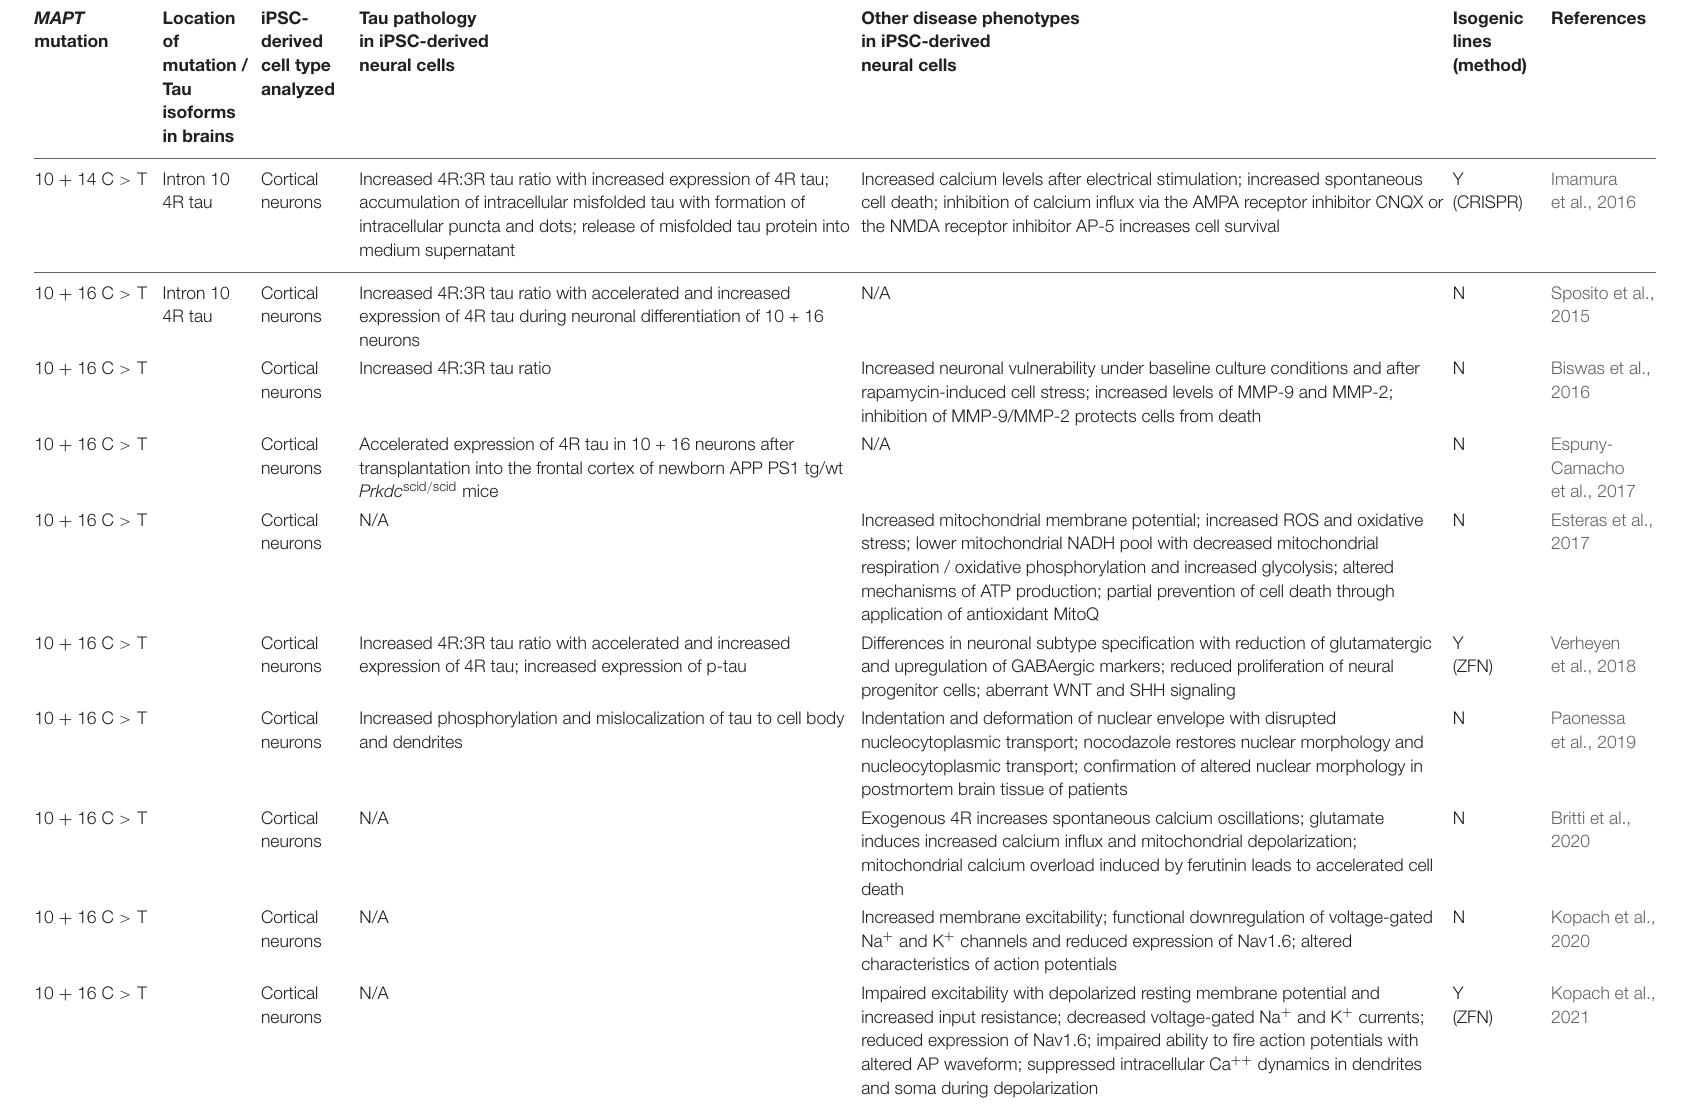
TABLE 2 | Induced pluripotent stem cell models of FTLD-tau linked to MAPT mutations in intron 10. MAPT